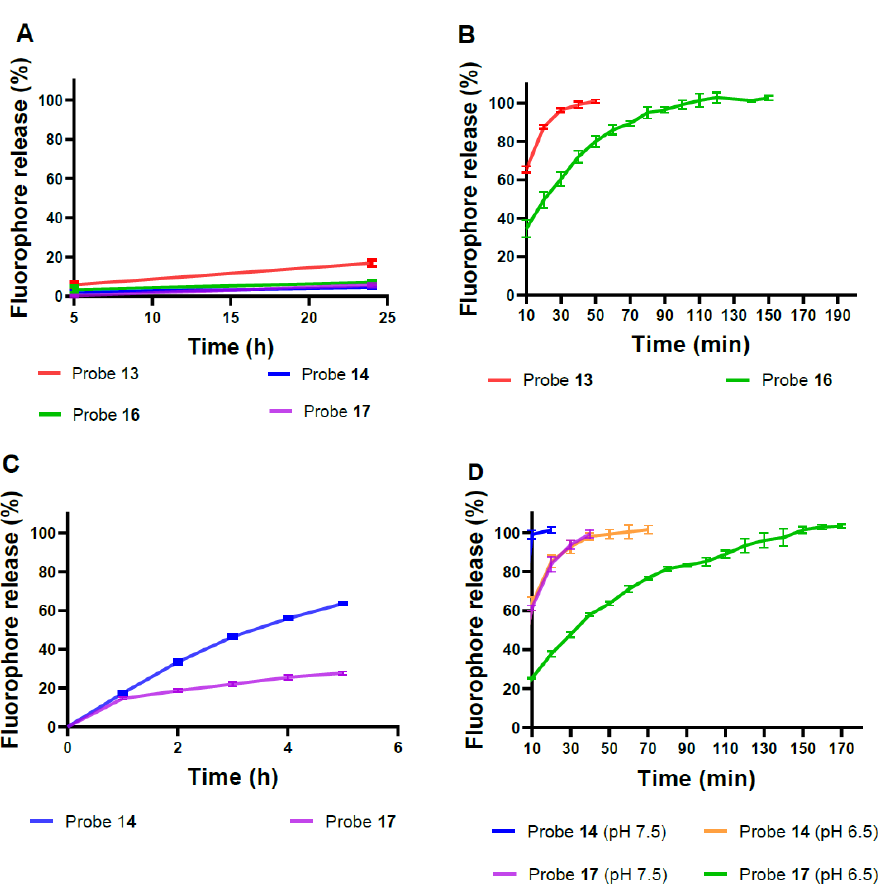
Figure 2. The correlation of the free fluorophore release with respect to time. ( A ) Probes 13–14 , 16–17 incubated in (HCl/KCl)/EtOH (1:1 v/v, pH = 1.2). ( B ) Probes 13, 16 incubated in acetate buffer/EtOH (1:1 v/v, pH = 5.0). ( C ) Probes 14, 17 incubated in acetate buffer/EtOH (1:1 v/v, pH = 5.0). ( D ) Probes 14, 17 incubated in PB/EtOH (1:1 v/v, pH = 7.5) and PB/EtOH (1:1 v/v, pH = 6.5). All the experiments were at 37 °C and 25 µM concentrations. Values were recorded in triplicate. Error bars are S.E.M.